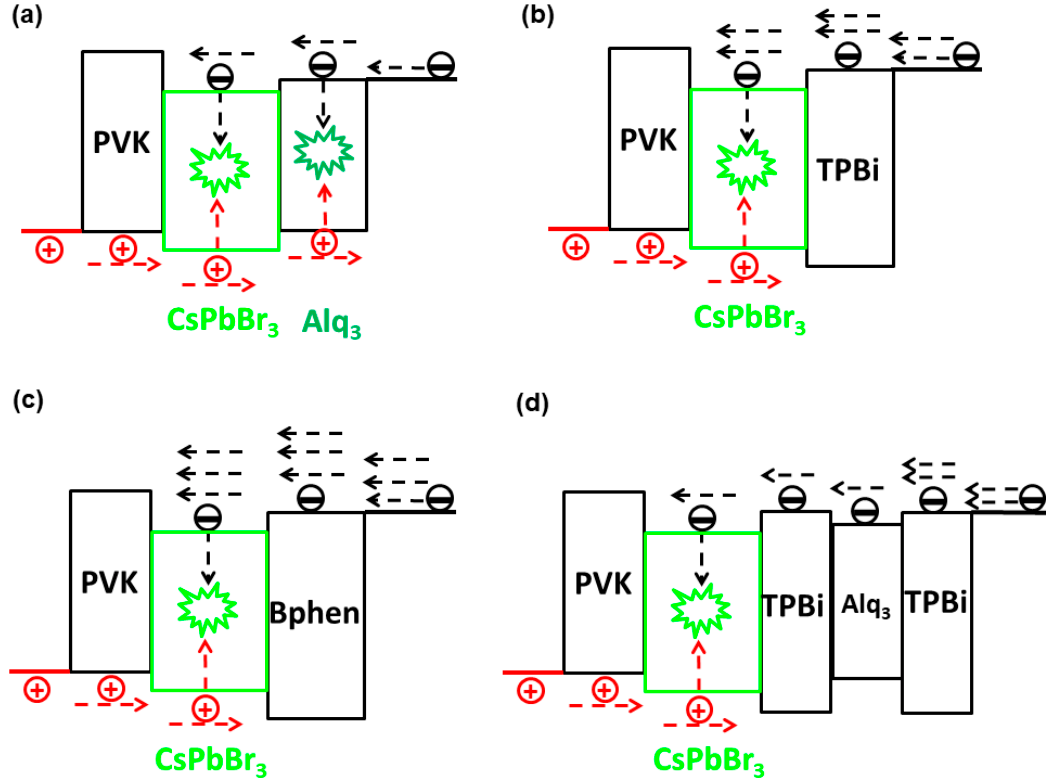
Figure 7. The working mechanisms of PeLEDs using different electron transport layers (ETLs): ( a ) Device G1, ( b ) Device G2, ( c ) Device G3, and ( d ) Device G4. Red and black arrows represented the hole and electron transport, respectively. Reproduced from reference [202], John Wiley and Sons, 2018.